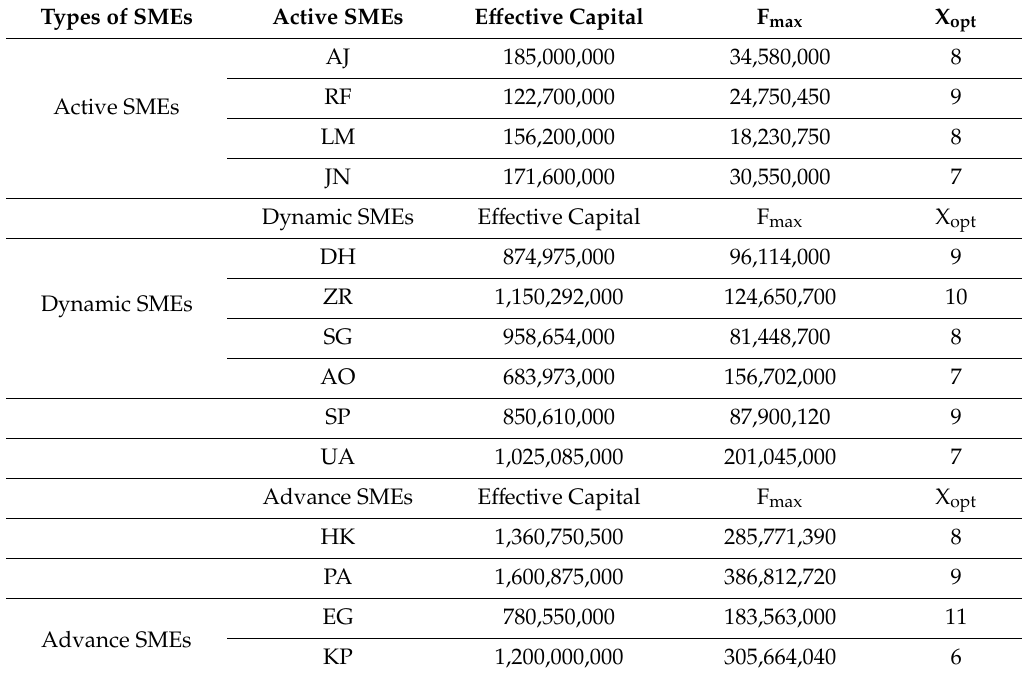
Table 5. The results of